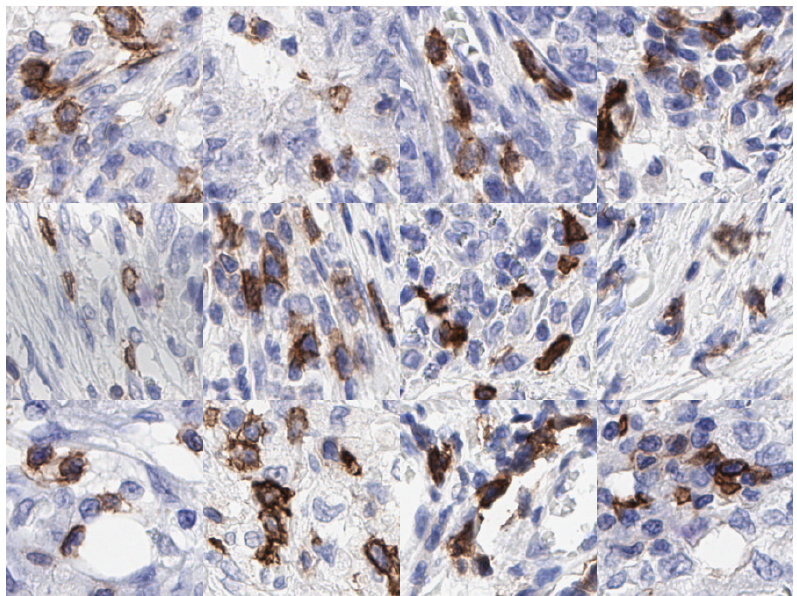
Figure 1. Examples of IHC patches extracted at 40 × magnification containing ICOS positive (i.e., brown cytoplasmic and blue nuclear staining) and ICOS negative (blue nuclear stain only) cells in colon